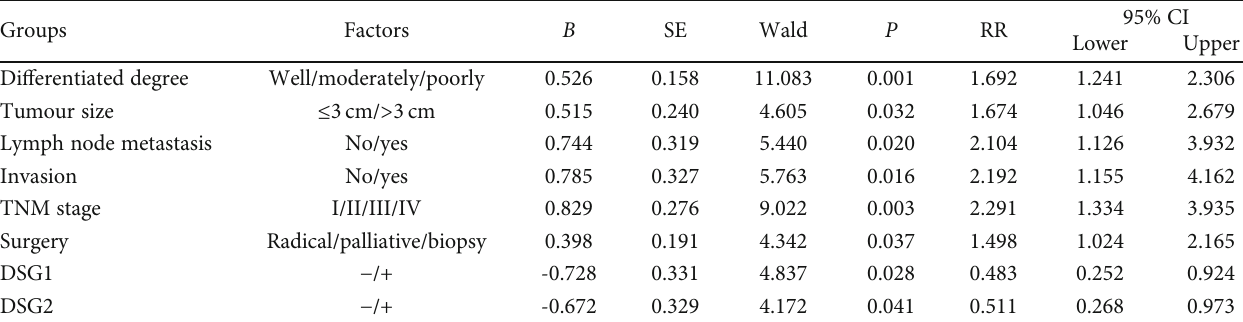
Table 5: Multivariate Cox regression analysis of survival rate in patients with EHCC and DSG1 and DSG2 expression.